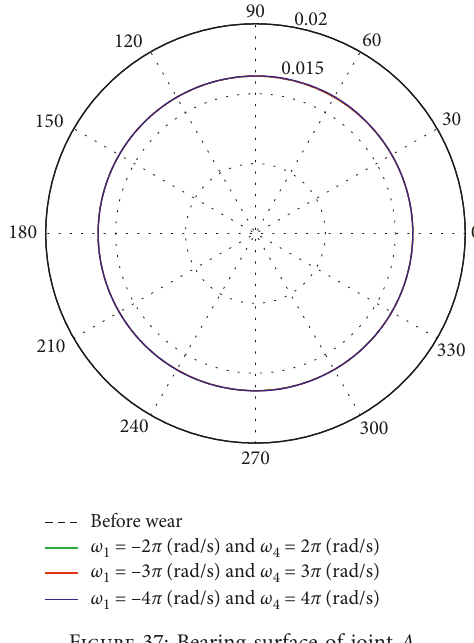
Figure 37: Bearing surface of joint A .